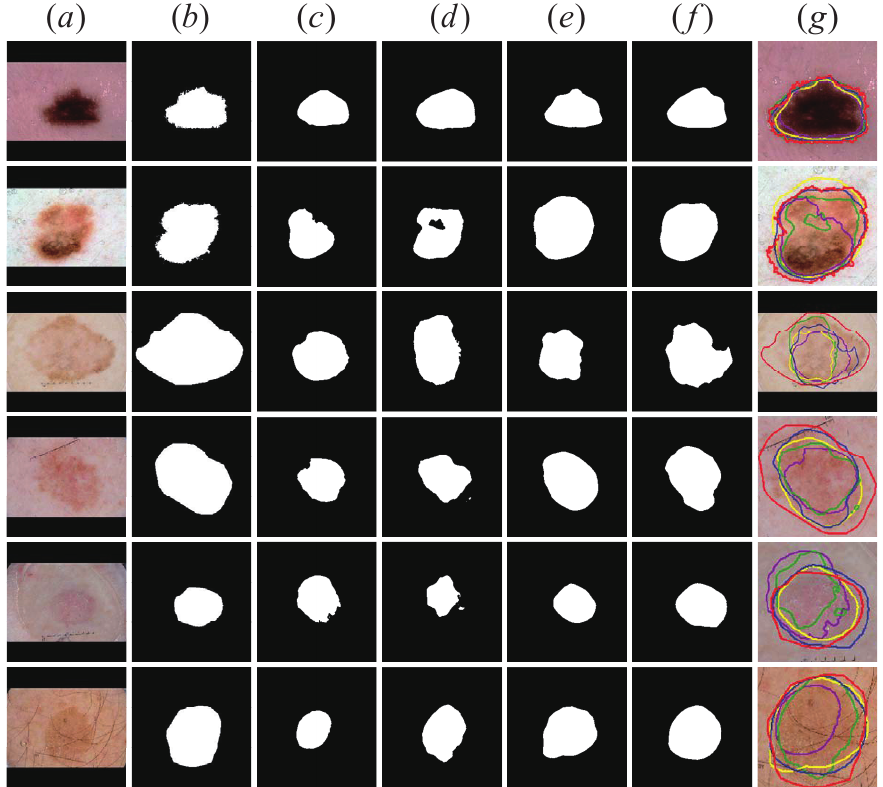
Figure 9. Visualization results of the attention module ablation. The first two lines are Benign Nevus, the middle two lines are Melanoma lesions, and the last two lines are Seborrheic Keratosis lesions. ( a ) Original skin lesion image; ( b ) Ground truth corresponding to the lesion; ( c ) SE Block+Baseline model lesion segmentation results; ( d ) FPA+Baseline model lesion segmentation results; ( e ) CBAM+Baseline model lesion segmentation Results; ( f ) CSAG and DCCNet (ours) model lesion segmentation results; ( g ) ground truth (red) and SEnet+Baseline (purple), FPA+Baseline (green), CBAM+Baseline (yellow) and ours (blue) segmentation Results comparison chart. All pictures are